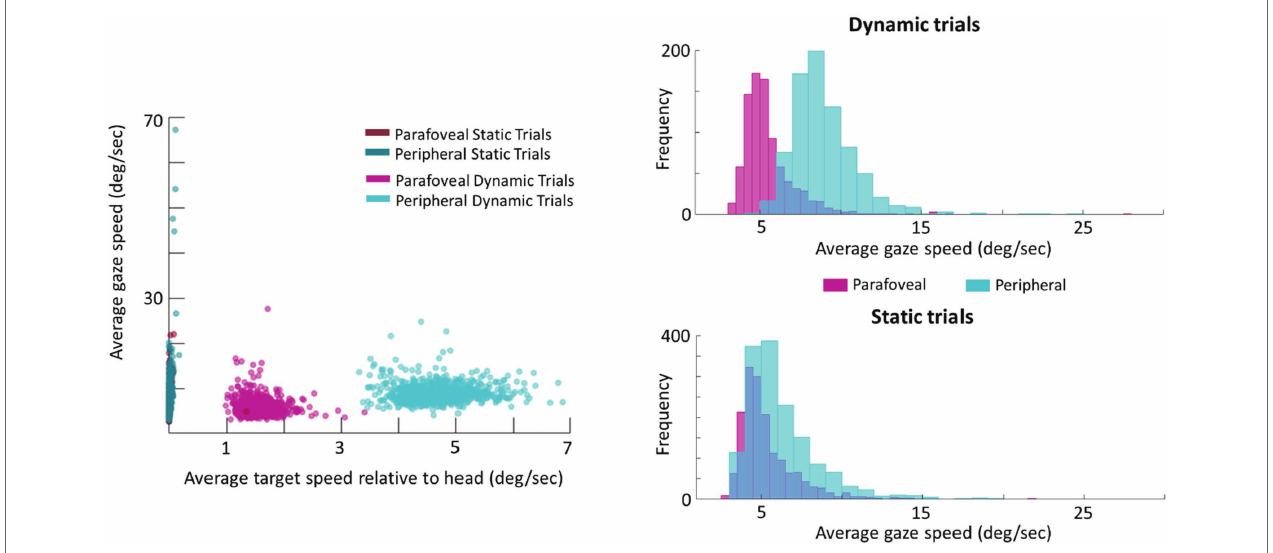
FIGURE 7 | Scatter plot of average gaze speed compared to average target speed (left). Histogram of gaze speed for Dynamic trials (right, top) and Static trials (right, bottom).